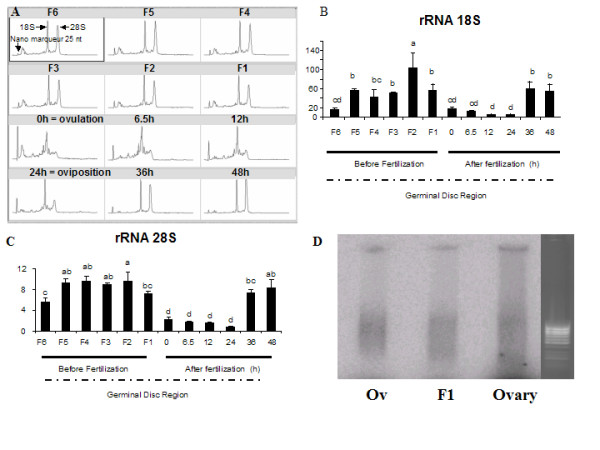
Ribosomic and messenger RNA profiles during oocyte maturation and early embryo development. Total RNA was extracted from the GDR of an oocyte or from the embryo. RNA quality was assessed using nanochips (Agilent technologies) as described in the Materials and Methods. This analysis represents rRNA 18S and 28S subunit profiles in the samples (A). Ribosomic RNA 18S and 28S subunit profiles were then confirmed by real time PCR analysis (B and C, respectively) using the TaqMan kit (Eurogentec) as described in the Materials and Methods. Labelled 32P reverse transcription was performed to investigate the quality of mRNA extracted from F1 GDR, Ov GDR and from the ovary. The radioactive signal for samples and ethidium bromide staining for the ladder are shown (D).